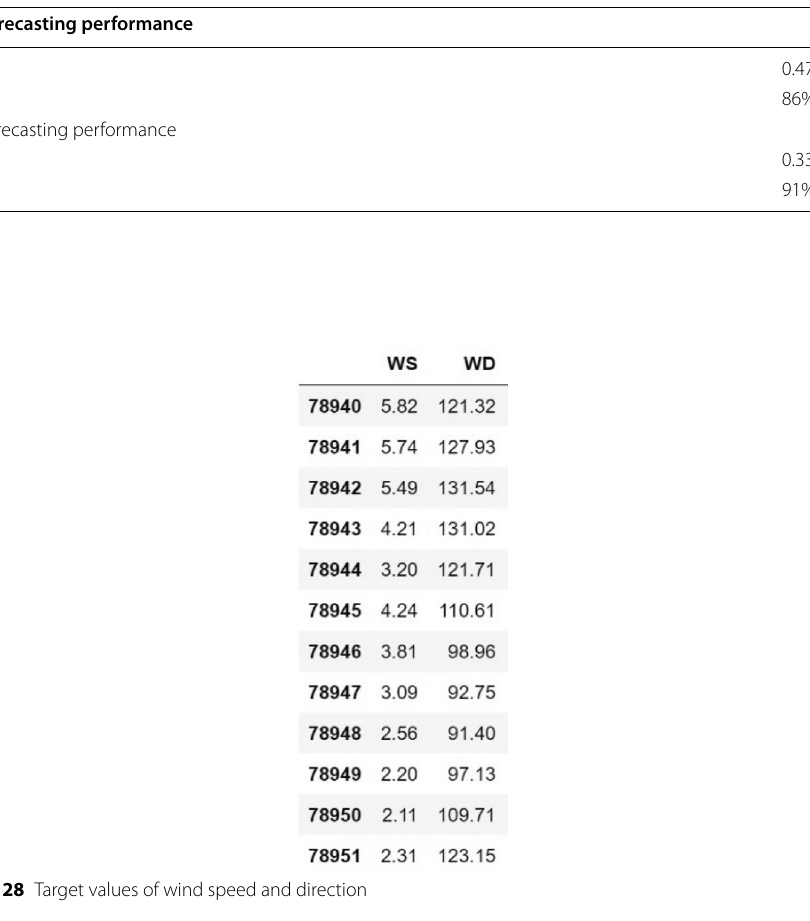
Table 4 W x and W y forecasting performance